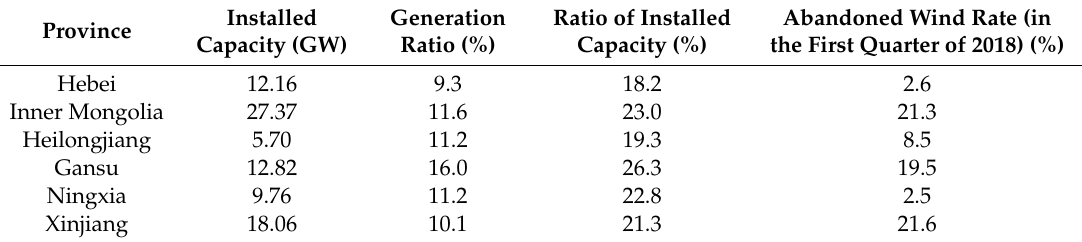
Table 1. Application of wind power in some provinces, data sourced from [35].